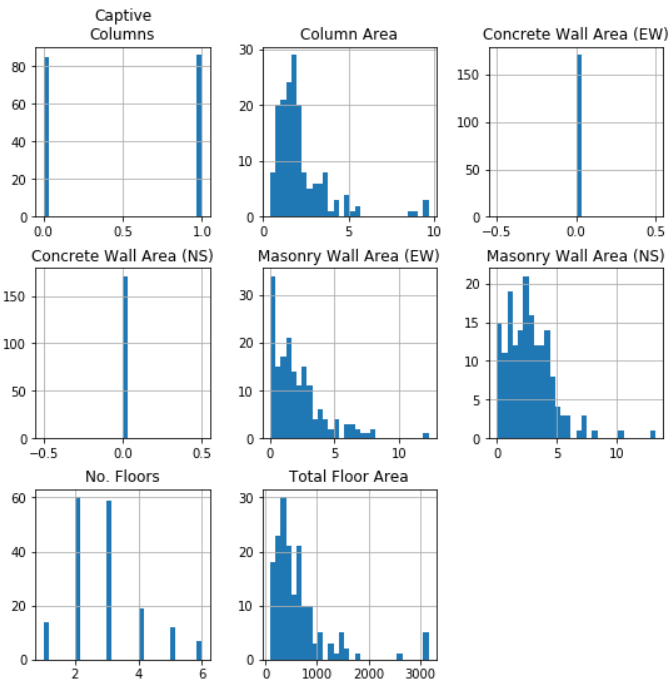
Figure 4. Ecuador’s histogram plots show that each parameter’s data or value in the input dataset spreads disorderly. The result affects the stability and predictability of the classifier. The other three input datasets follow the identical